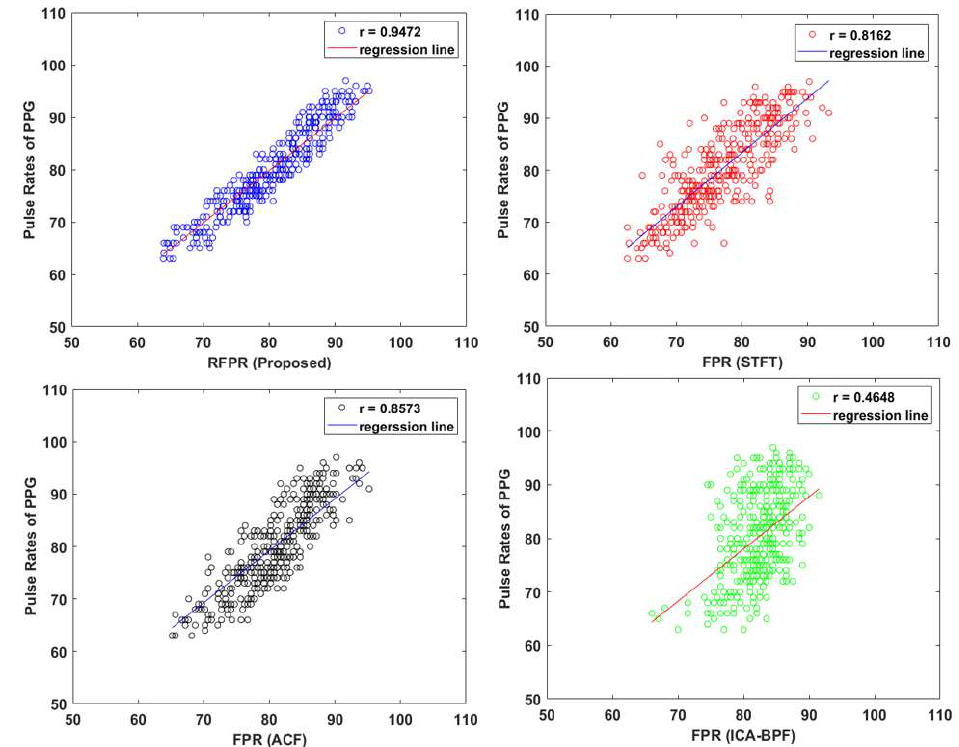
Figure 22. Graphs comparing RFPR with other FPR methods (STFT, ACF, ICA–BPF).